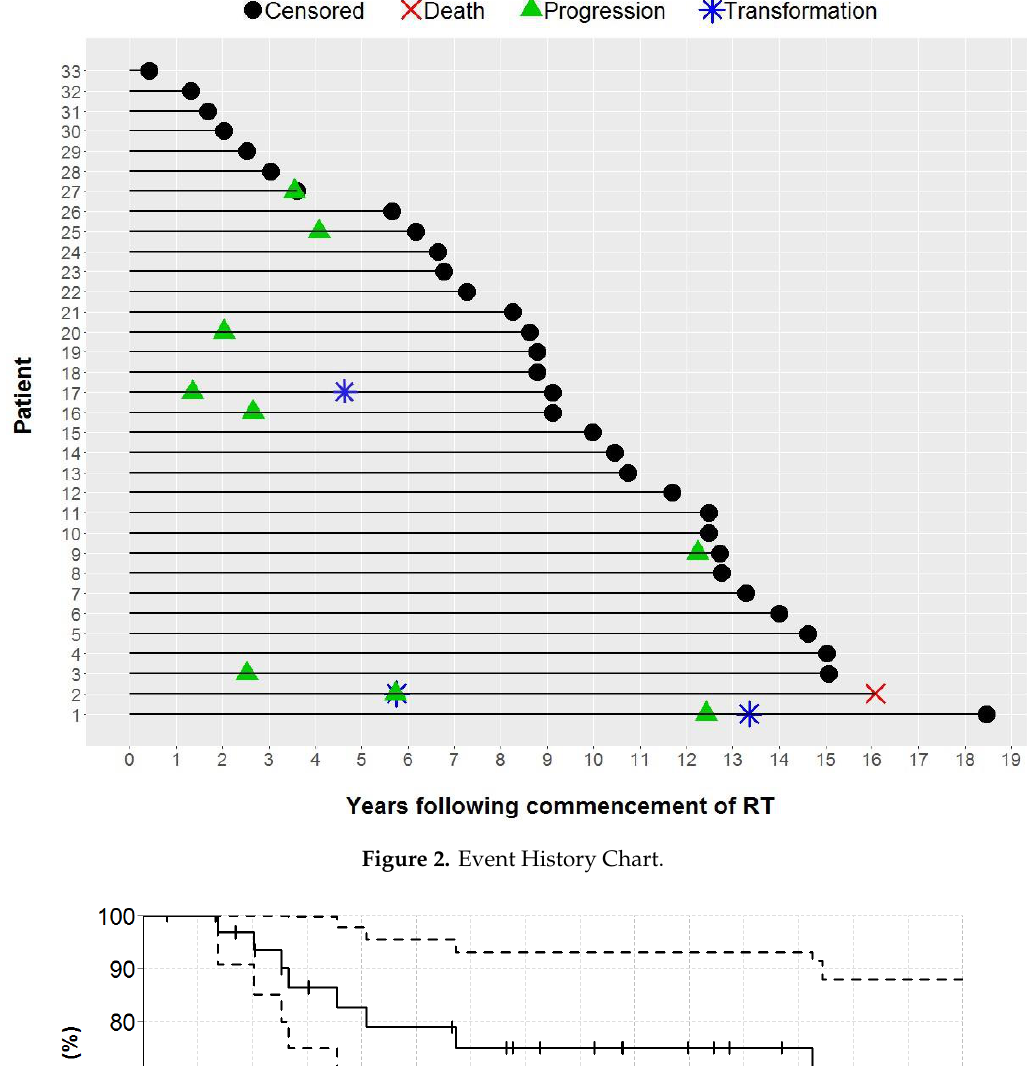
Figure 2. Event History Chart.